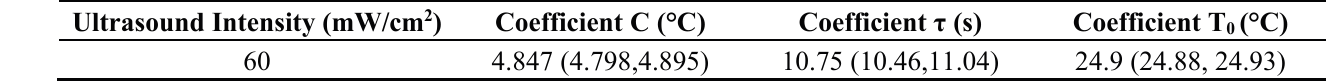
Figure 6. Curve fitting results for temperature rise data by MATLAB’s curve fitting box (60 mW/cm 2 ). Table 3. The coefficients of the first transient model curve fitting.